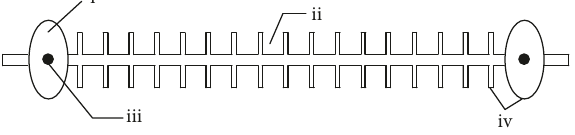
Figure 2: Tabular EKG.